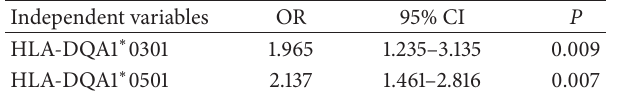
Table 7: Independent risk factors of DN in diabetic